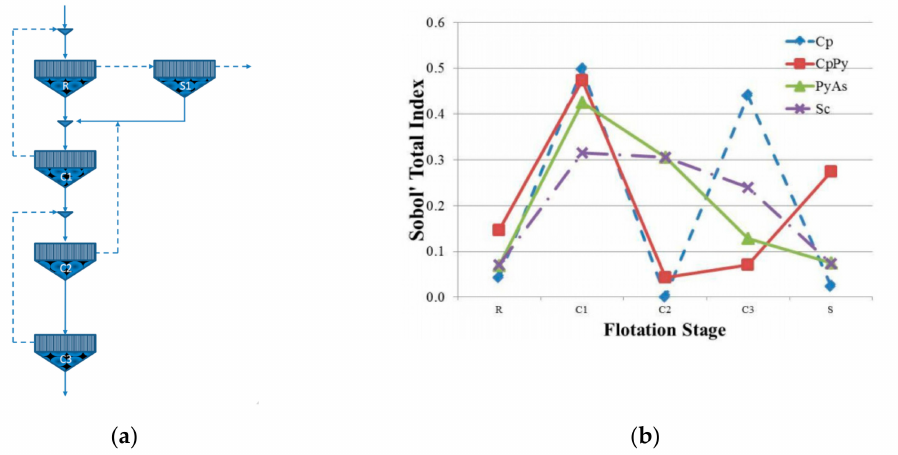
Figure 13. ( a ) Designed circuit using the methodology. ( b ) Sobol total index for each stage and for chalcopyrite (Cp), chalcopyrite–pyrite (CpPy), pyrite–arsenopyrite, and silica (Sc)